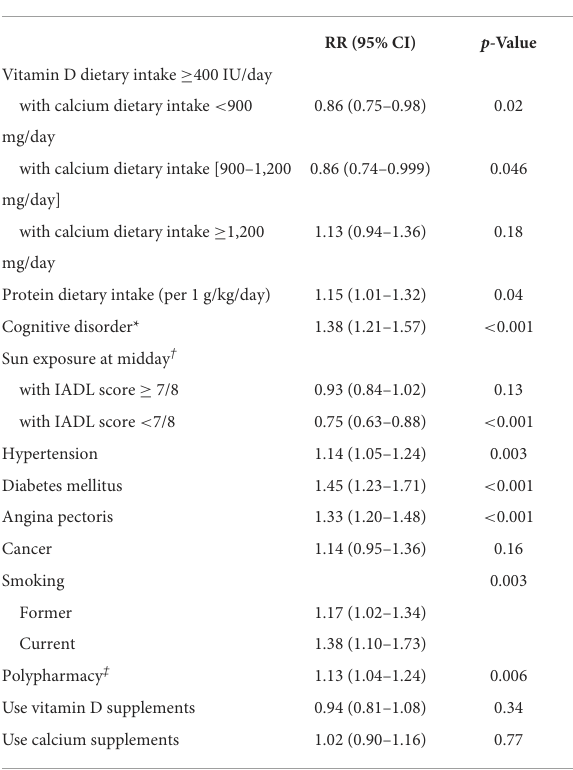
Cox model stratified